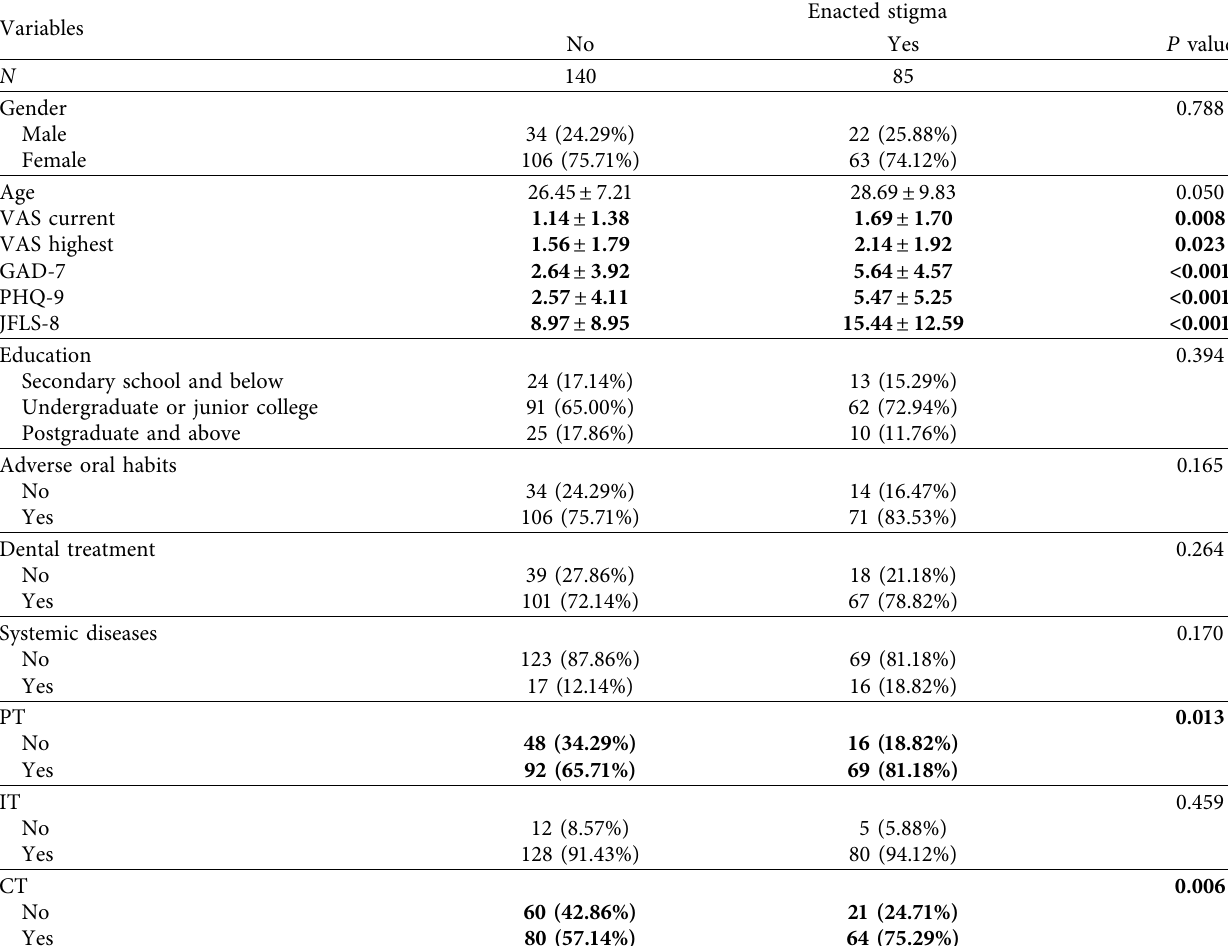
Table 4: Effects of clinical characteristics and quantitative variables on enacted